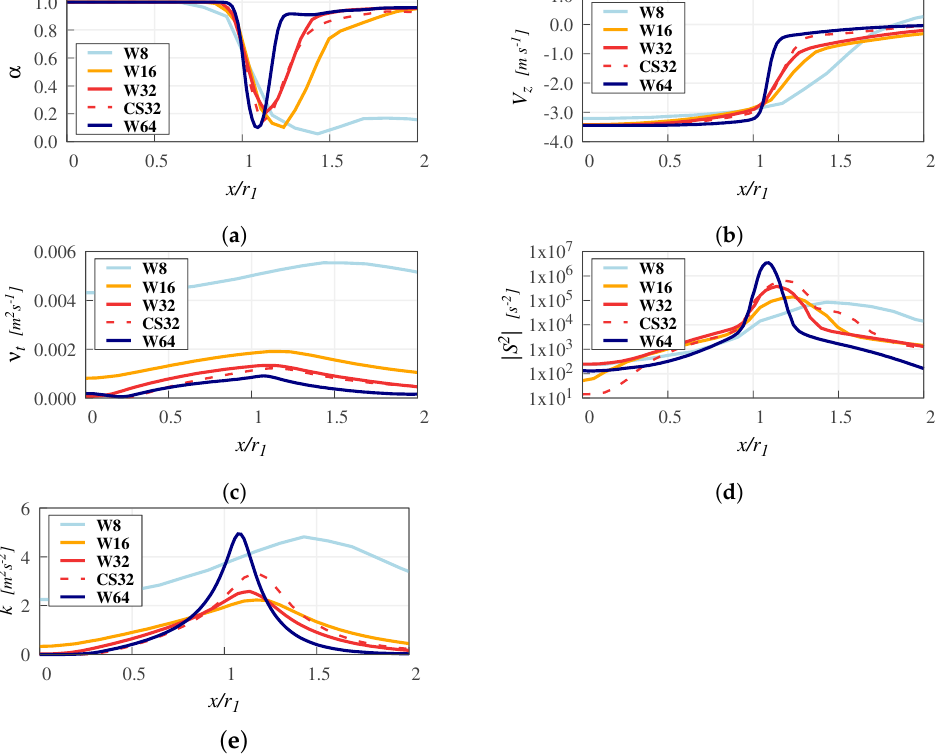
Figure 2. Impinging jet—mesh dependency. Profiles at z = − 0.03 m: ( a ) α . ( b ) V z . ( c ) ν t . ( d ) | S | 2 . ( e ) k